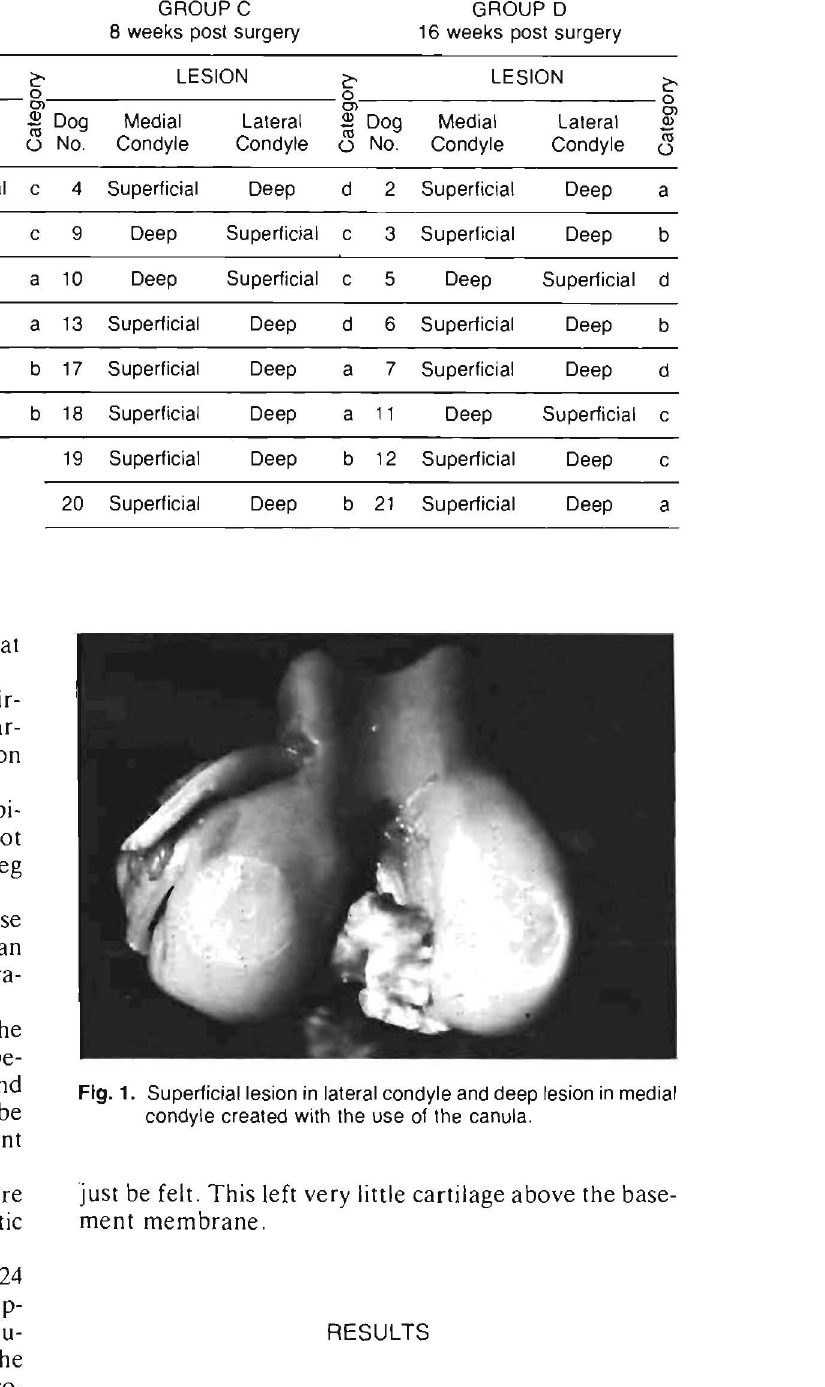
just be felt. This left very little cartilage above the base ment